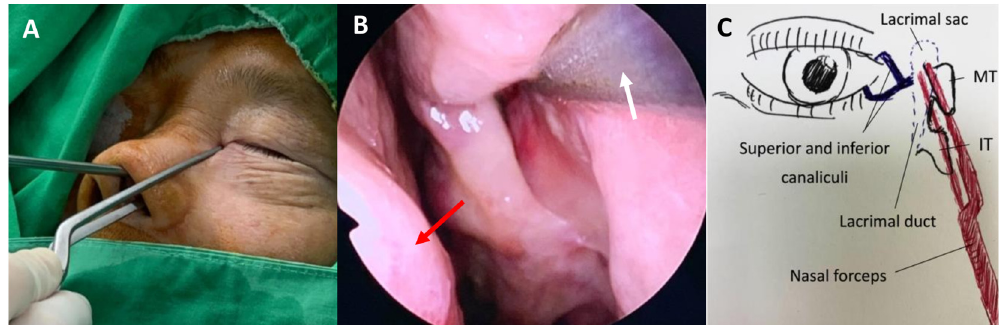
Figure 3. Intraoperative view of endoscopic dacryocystorhinostomy and illustration demonstrating the use of a Jansen bayonet nasal forceps to localize the lacrimal sac. ( A ) The outer tip of the forceps aligned with the medial canthus where the lacrimal sac was located. ( B ) The inner tip of the forceps pointed to the corresponding intranasal position of the lacrimal sac. The yellow arrow indicates the nasal septum, and the white arrow indicates the inner tip of the Jansen bayonet nasal forceps. ( C ) An illustration of lacrimal system anatomy showing the inner and outer tip of nasal forceps abut against the position of lacrimal sac. MT = middle turbinate; IT = inferior turbinate.